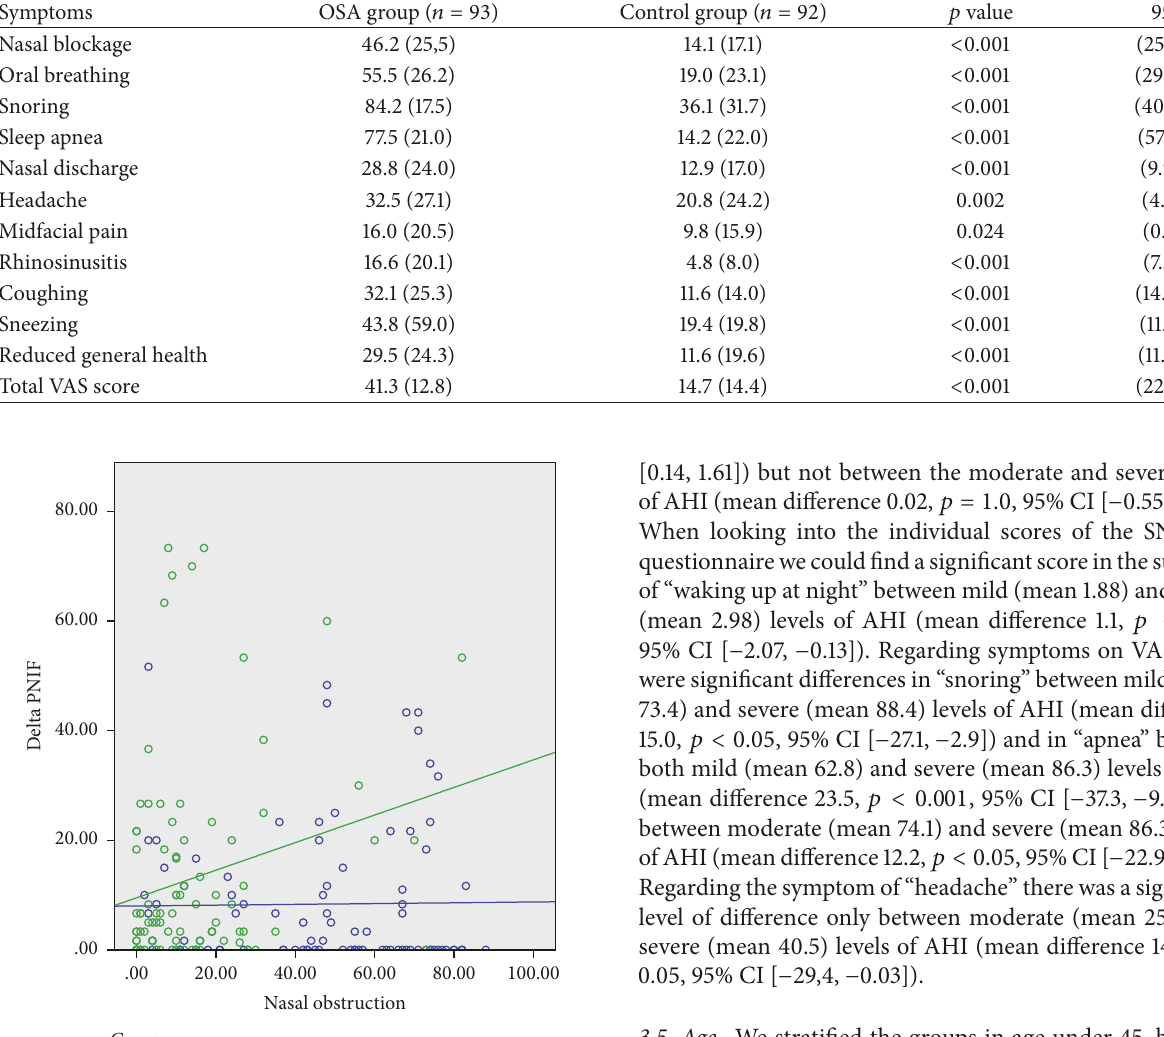
Table 3: Visual Analog Scale (VAS) scores for sinonasal symptoms in OSA patients and controls. Data presented as mean (SD) and 95% CI.